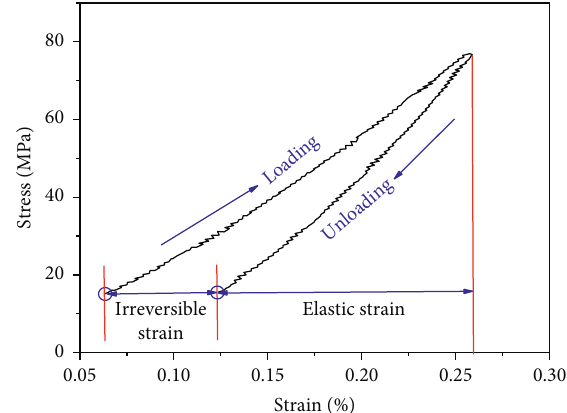
Figure 3: Sketch of irreversible strain.